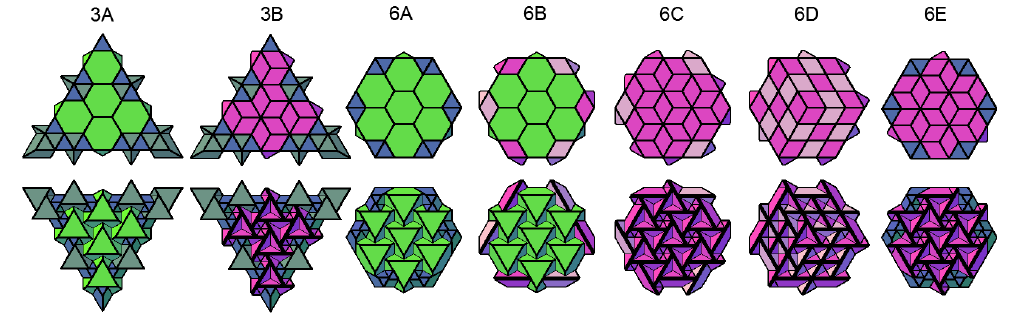
Figure 11. Modeling of one-sided smooth components based on: ( a ) a regular hexagon; ( b , c ) an equilateral triangle; and ( d , e ) a rhombus. Figure 12. Triangular and hexagonal slab structures inspired by Abeille vaults.